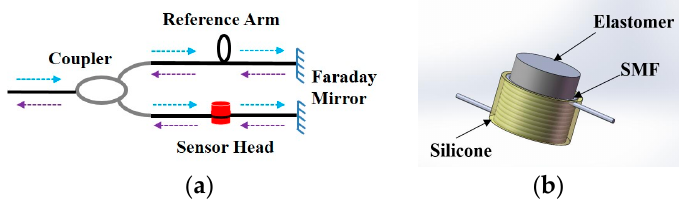
Figure 1. Schematic diagram of ( a ) the Michelson interferometer-based fiber sensor and ( b ) the sensor head constructed by winding optical fiber on the elastic cylinder: the single-mode fiber (SMF).